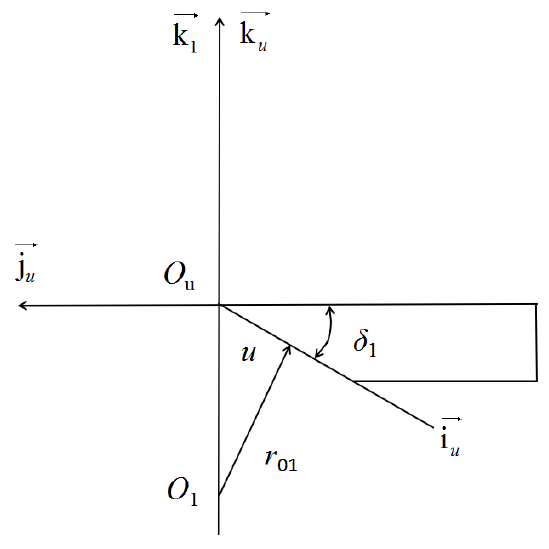
Figure 5. Diagram of cutter edge.